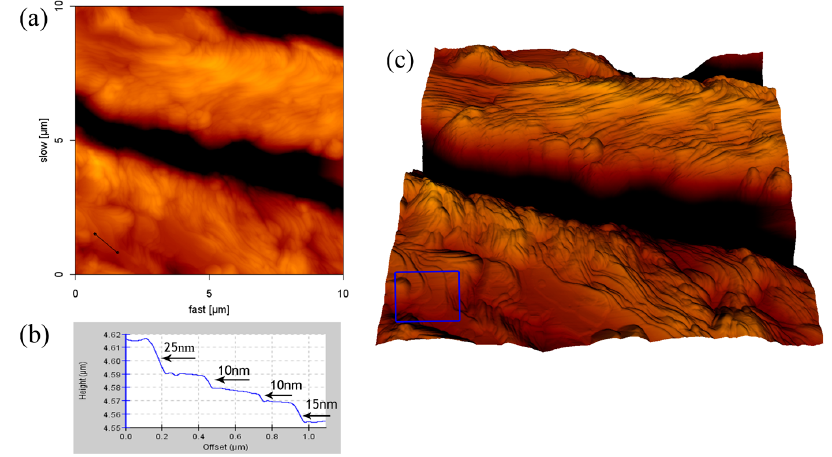
Figure 5. AFM result of SDS aggregates of the surface of the glass: ( a ) height image; ( b ) cross-section height profiles along the line in (a); and ( c ) 3D reconstruction image.